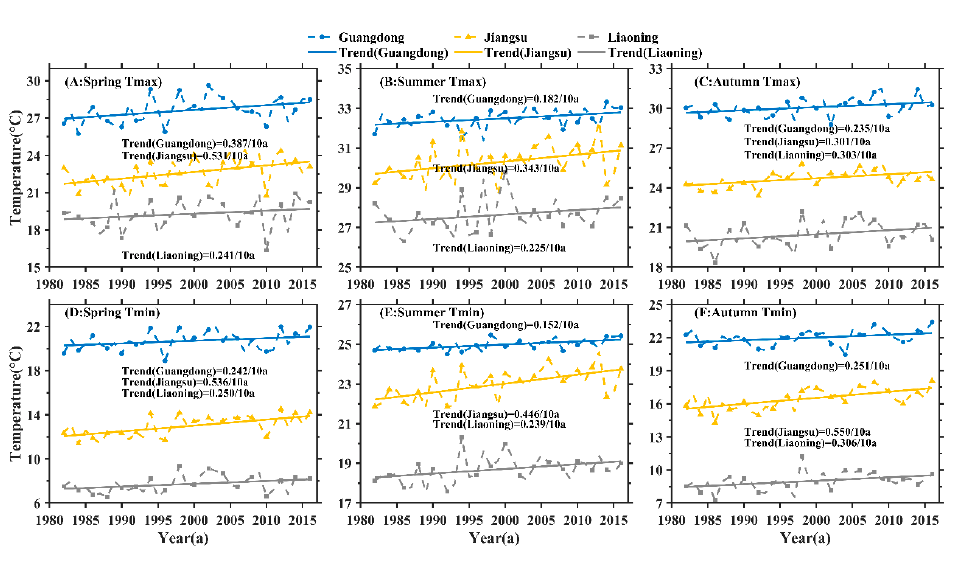
Figure 2. Historical trends of the maximum and minimum temperatures in spring, summer and autumn in the growing season (April–October) from 1982 to 2016 in Guangdong, Jiangsu and Liaoning.